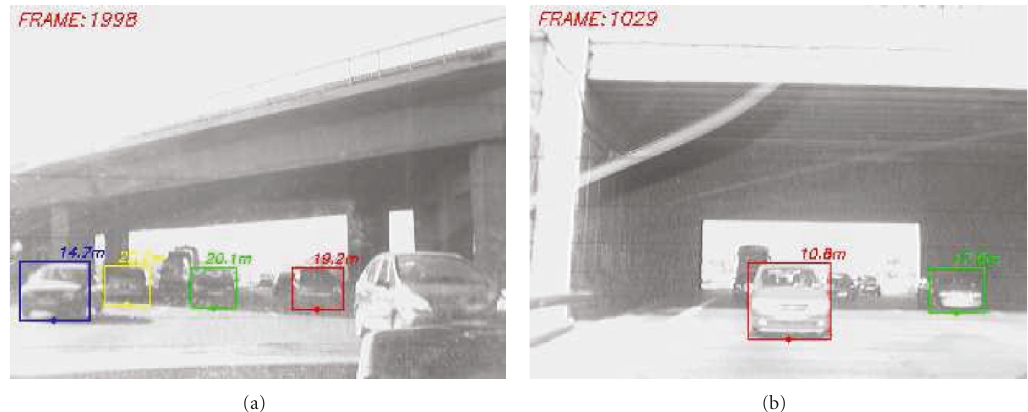
Figure 17: Examples with strong illumination changes after passing beneath a bridge.